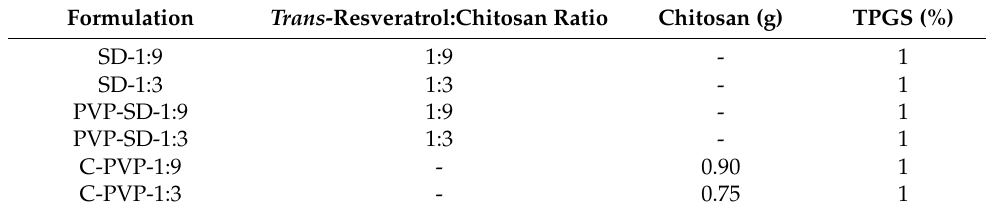
Table 1. Solid dispersion and PVP films